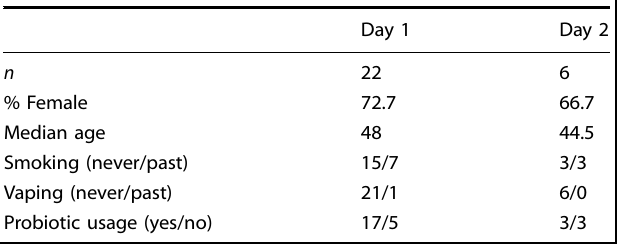
Table 1. Cohort description.